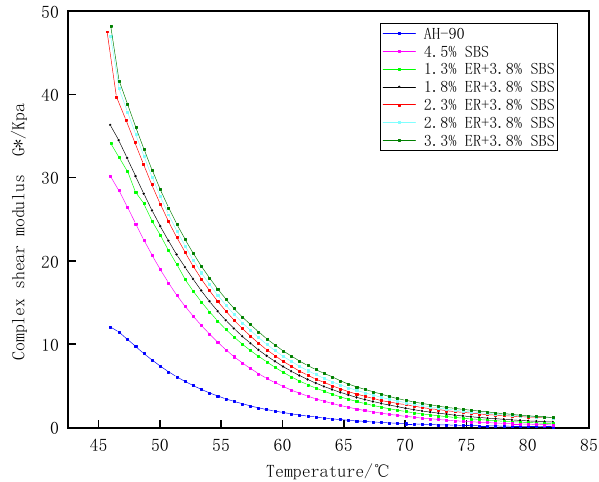
Figure 9. Effect of temperature on the shear modulus of ER/SBS modified bitumen.